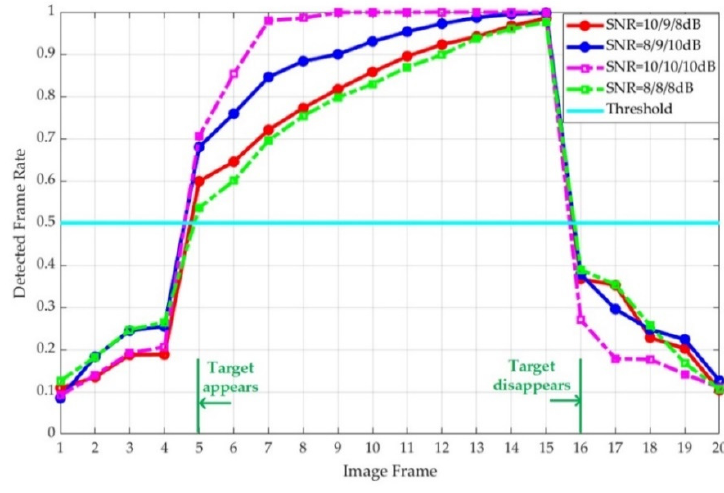
Figure 11. Detected frame rate in different update order cases.